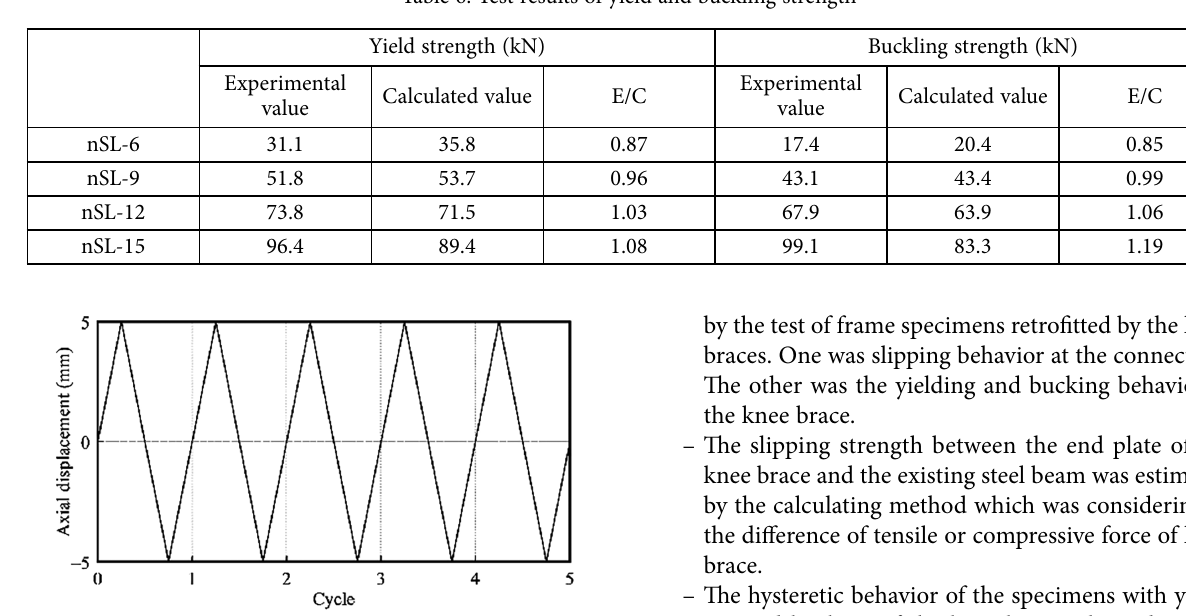
Table 6. Test results of yield and buckling strength